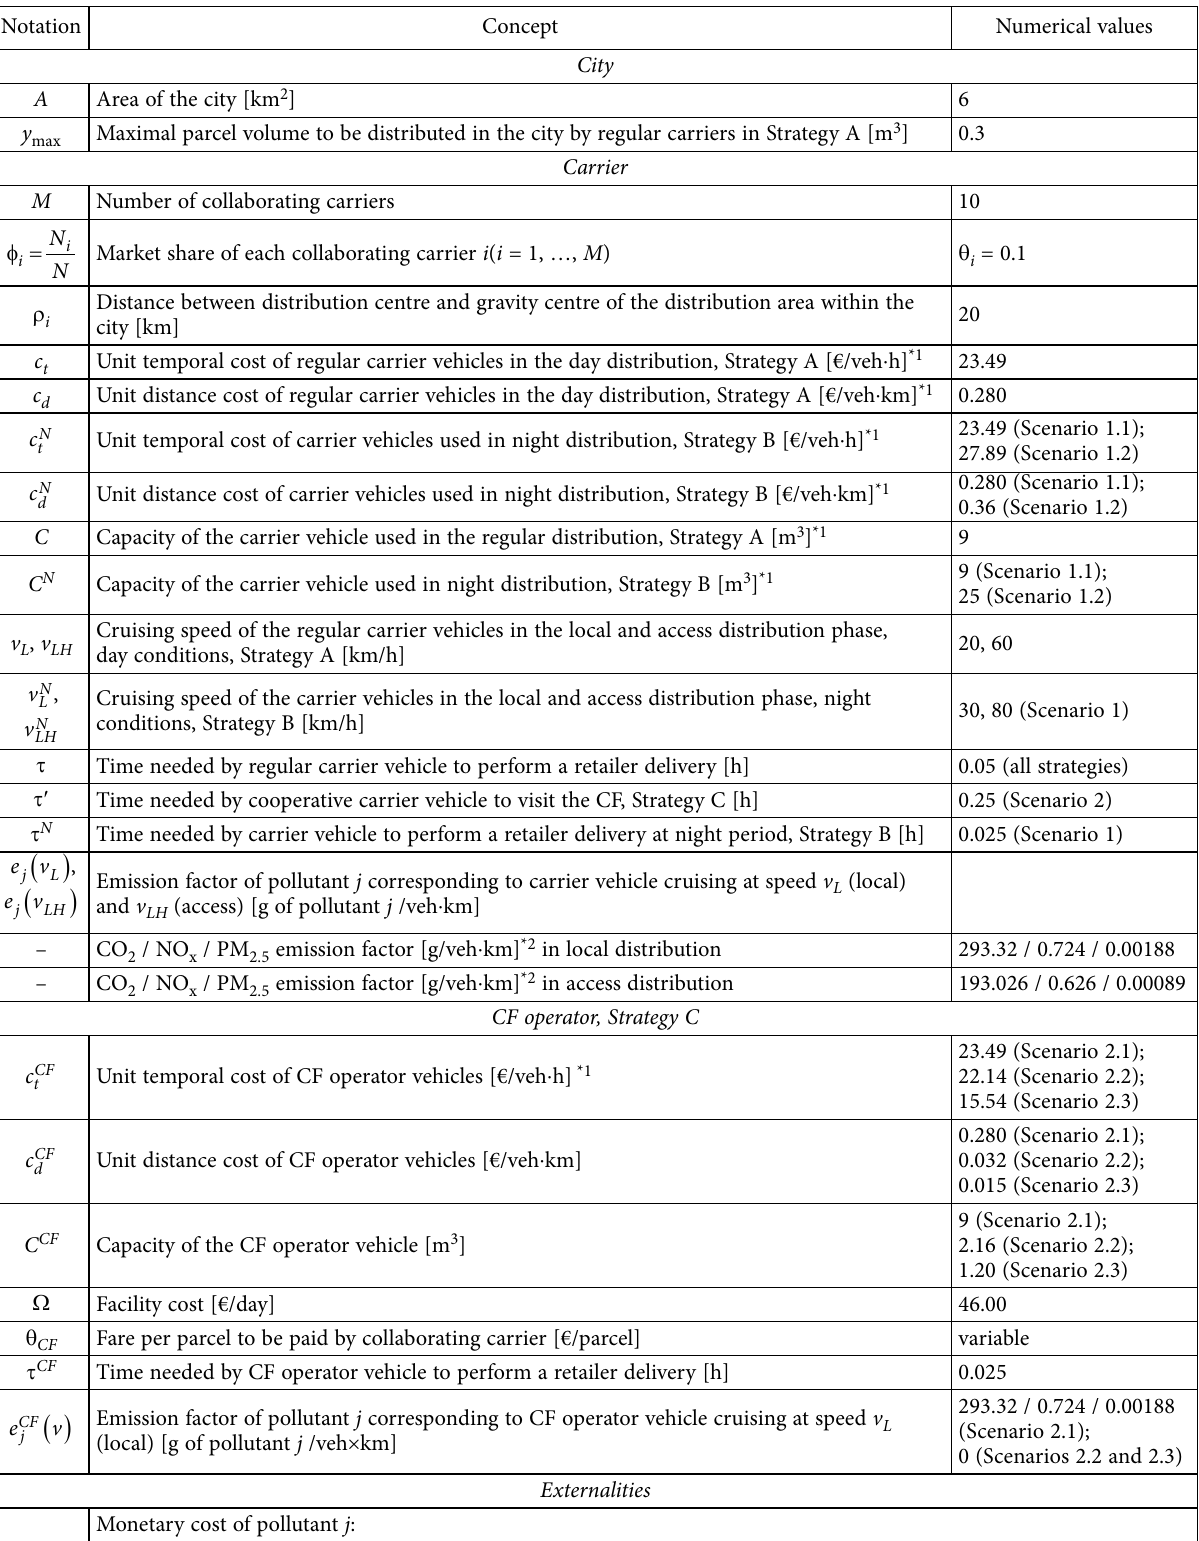
Table 1. Summary of the input parameters considered in the